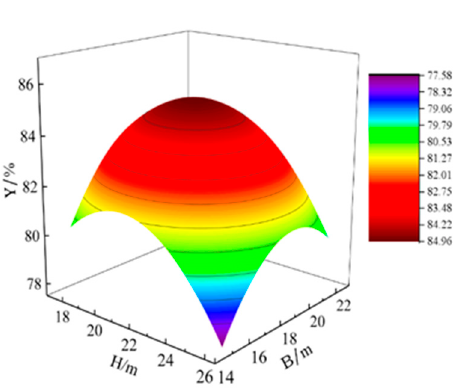
Figure 6. Relation curve of the difference between recovery and dilution ratio Y and sublevel height H and production drift spacing B. H and production drift spacing B.